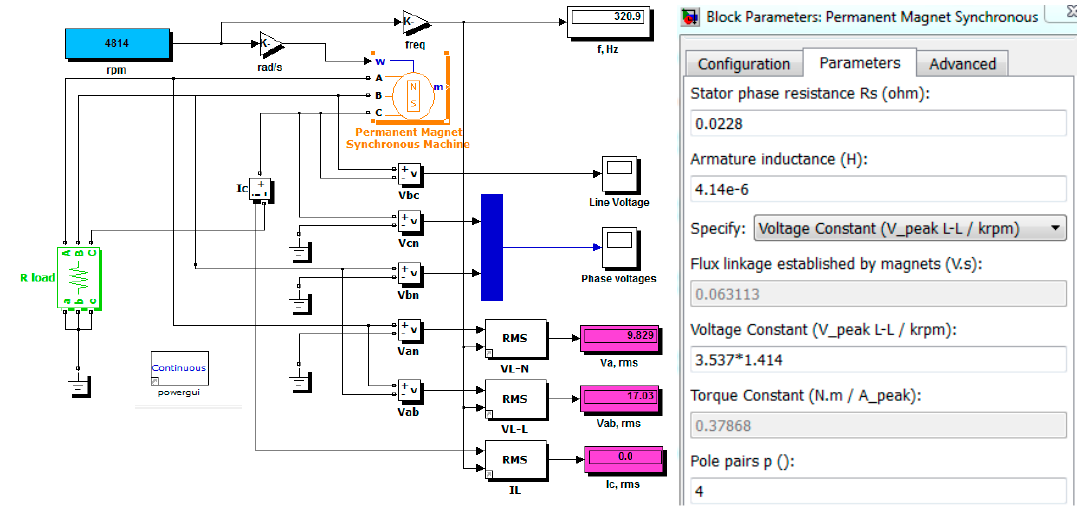
Figure 6. AFPMA MATLAB/Simulink model and parameter configuration.